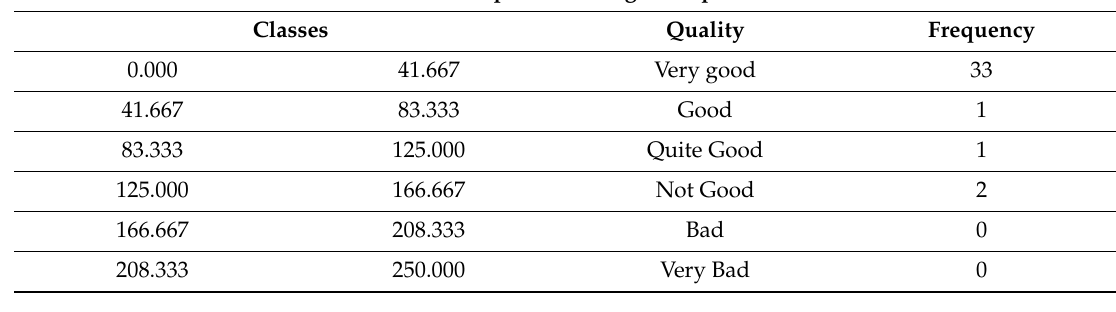
Table A1. Classification of area comparisons in Grobogan using the equal interval method between evaluation and reference datasets.